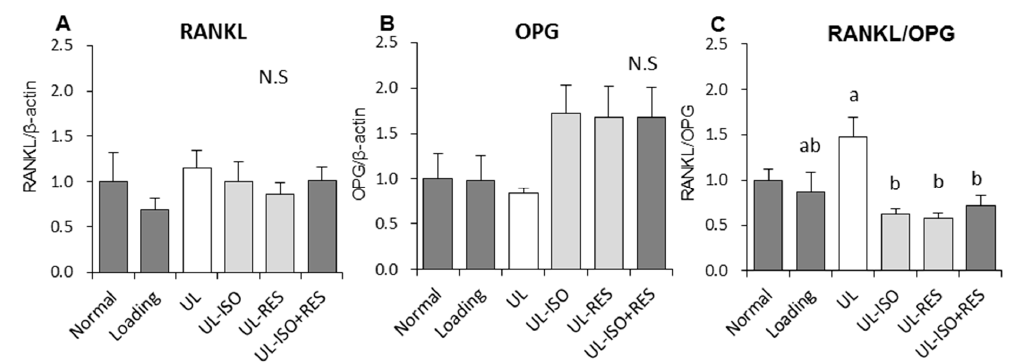
Figure 5. Bone metabolism-related gene expressions in bone marrow cells collected from in hindlimb- unloading mice. Expression levels receptor activator of nuclear factor kappa-B ligand (RANKL) and osteoprotegerin (OPG) were determined by quantitative real-time PCR. The ordinate axis indicates the relative amount of mRNA compared with Normal mice. Gene expression levels were normalized with β -actin. ( A ) RANKL. ( B ) OPG. ( C ) RANKL/OPG ratio. Normal, normally housed group; Loading, loading group; UL, hindlimb-unloading mice fed a control diet; UL-ISO, hindlimb-